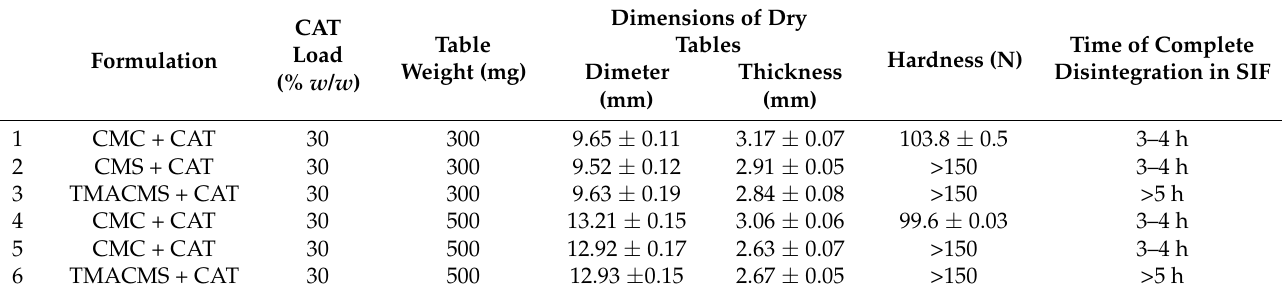
Table 1. Summary of the physical properties of tablets with 30% catalase (CAT) loading. The disintegration times were measured in 50 mL of simulated intestinal fluid (SIF) while incubated in a shaker at 37 ◦ C after being initially incubated for 1 h in simulated gastric fluid (SGF). CMC: CarboxyMethylCellulose, CMS: CarboxyMethylStarch, and TMACMS: